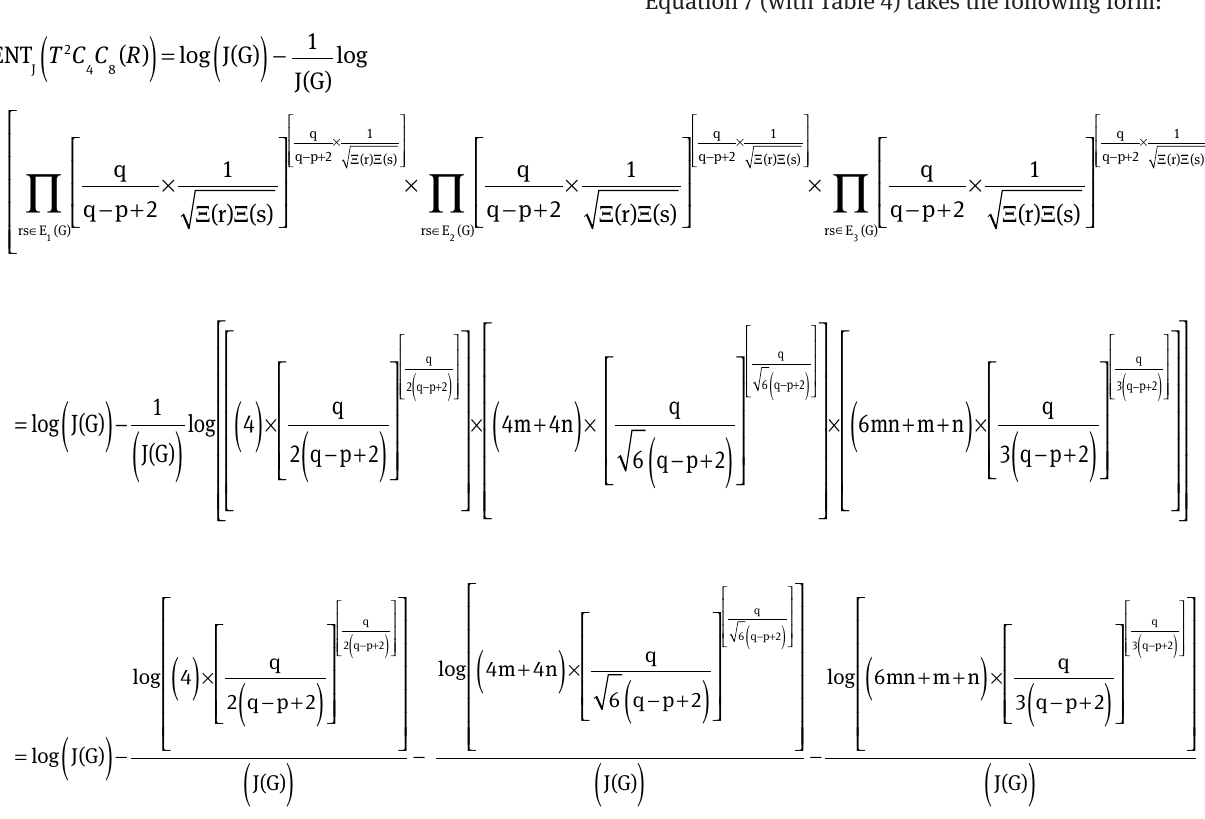
, ENT , ENT , and ENT entropies HM F AZI J